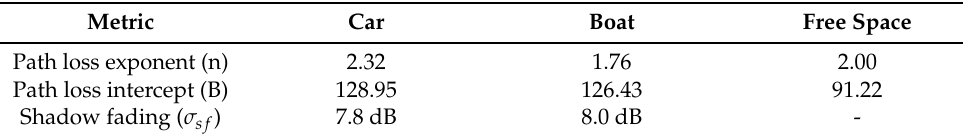
Figure 7. Oulu city path loss model in an urban environment: ( a ) DER as a function of the number of nodes; and ( b ) NEC as a function of the number of nodes. Table 3. Simulation parameters in the city of Oulu [36].